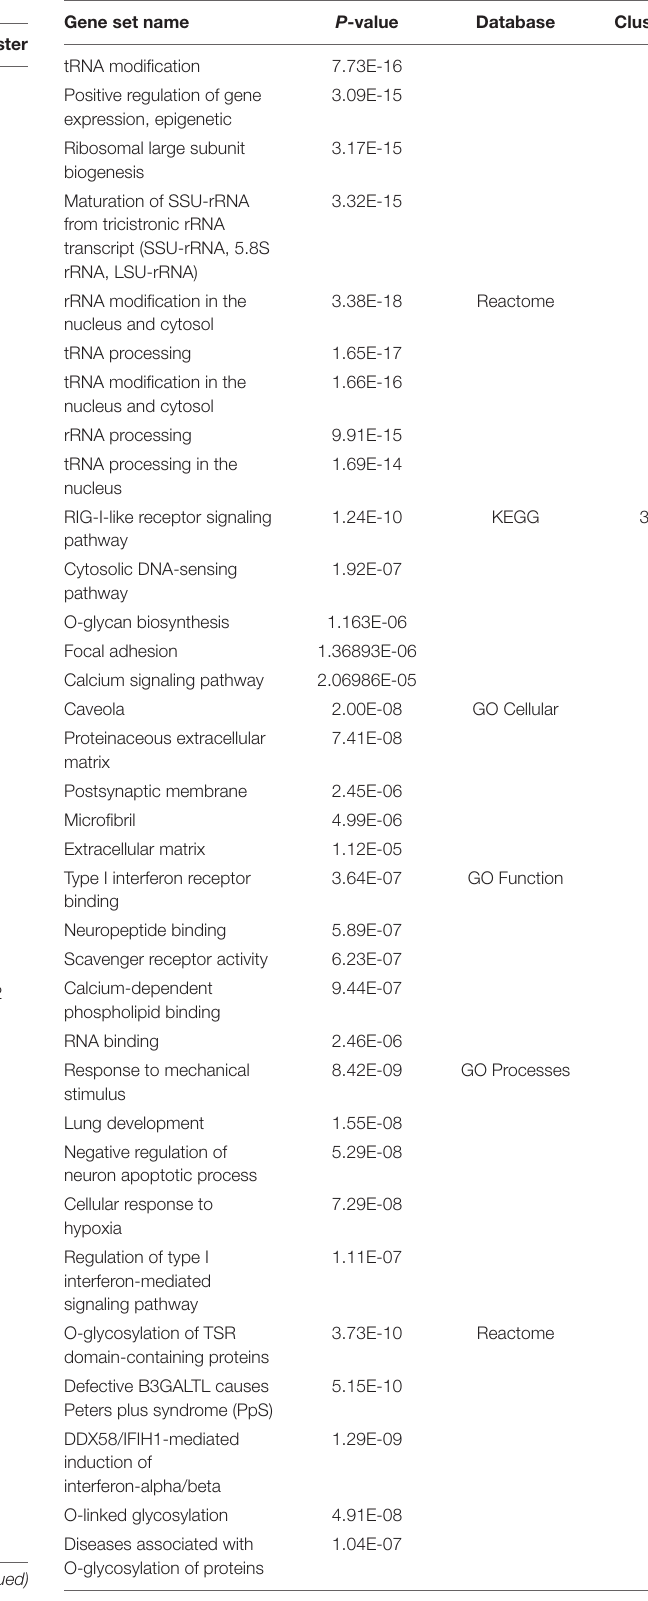
TABLE 3 | Gene ontology and pathway analyses of differentially expressed gene for the three largest clusters based on